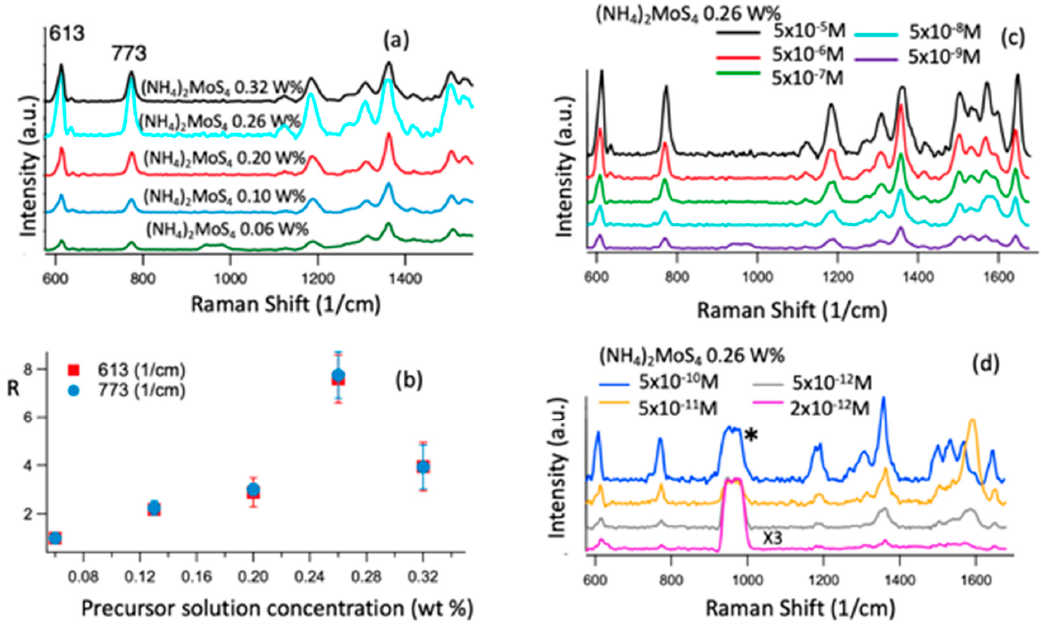
Figure 5. ( a ) Average Raman spectra of R6G molecules at the concentration of 5 × 10 − 5 M, collected from six batches of the samples shown in Figure S2, deposited on five MoS 2 /graphene nanohybrids substrates, MoS 2 was synthesized with a precursor solution concentration of 0.06 wt% to 0.32 wt%. ( b ) The corresponding enhancement factor of the 613 and 773 cm − 1 R6G peaks intensity on the five samples that were synthesized with different precursor solution concentrations with respect to the one was synthesized with a precursor solution concentration of 0.06 wt%. ( c , d ) Raman spectra of the R6G molecules with different concentrations in the range of 5 × 10 − 5 M to 5 × 10 − 9 M ( c ), and 5 × 10 − 10 M to 2 × 10 − 12 M (multiplied by 3) ( d ) on the MoS /graphene nanohybrids substrates, MoS 2 was synthesized with a precursor solution concentration of 0.26 wt%. The * mark denotes the Si peak.